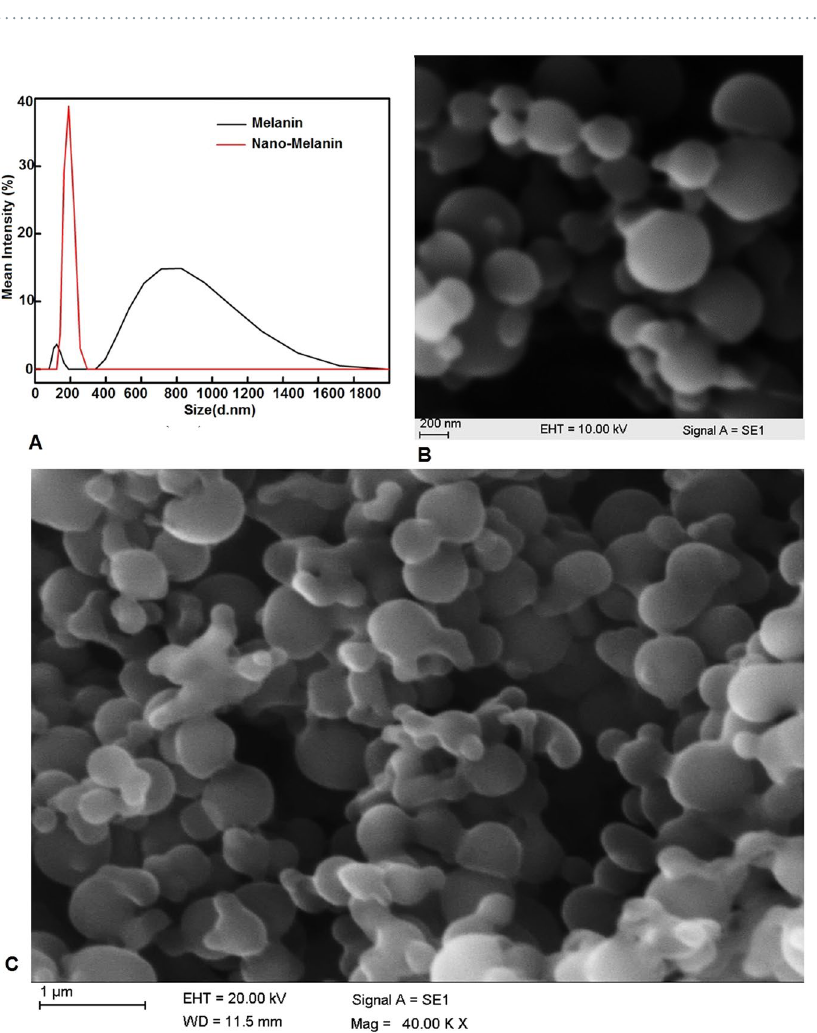
Figure 4. ( A ) peaks obtained for nanomelanin (black) and melanin (red) in the particle size anaylzer. ( B – C ) shows the SEM images of the